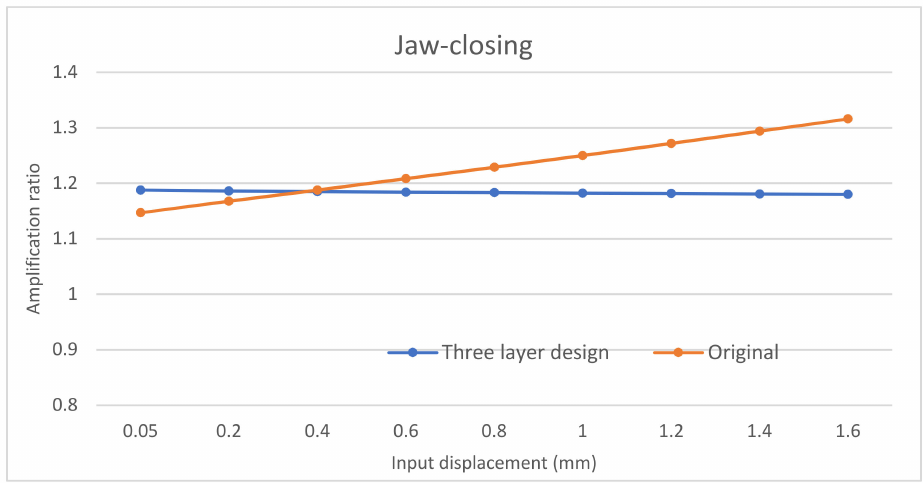
Figure 17. Constant amplification